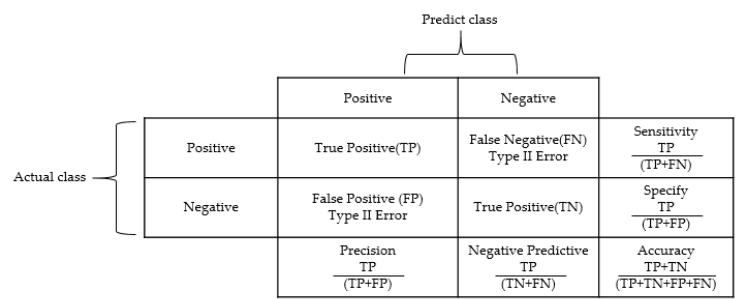
Figure 11. Confusion matrix.